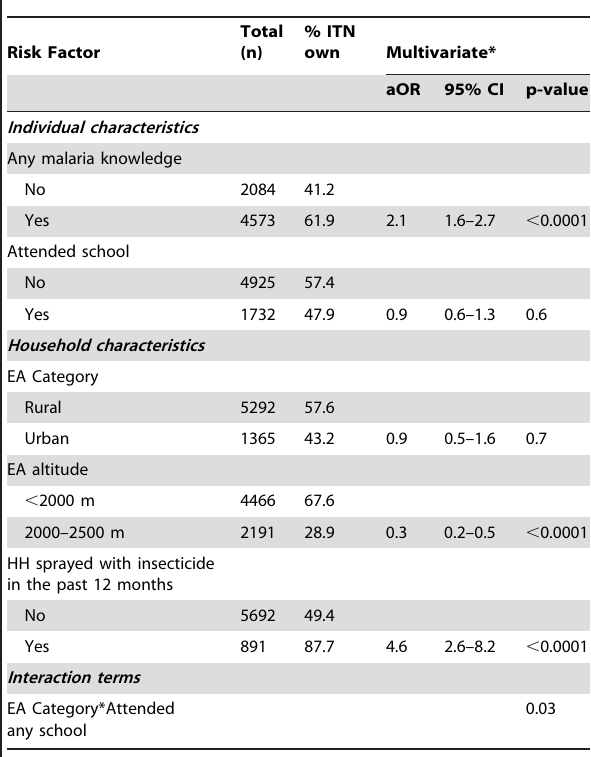
Table 4. Women’s knowledge of malaria as it predicts household ownership of